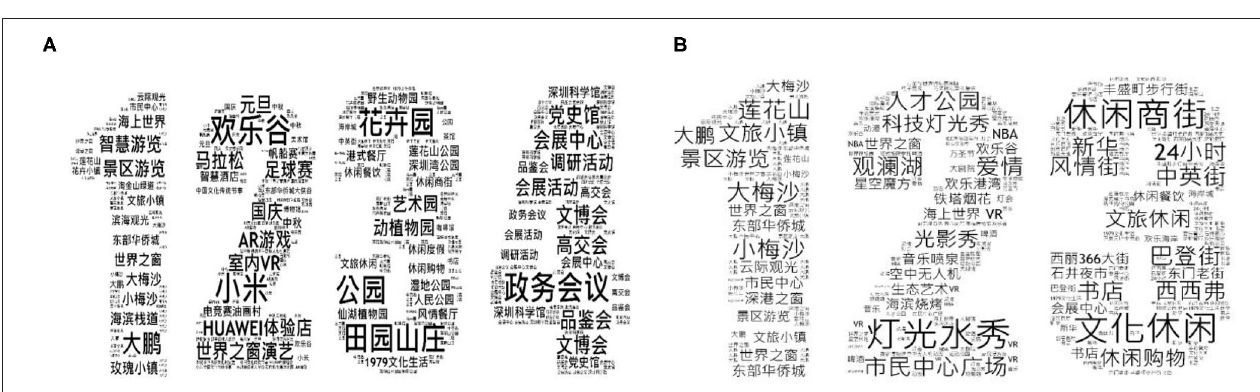
FIGURE 6 | Summary of word cloud diagram of daytime and night-time tourism economic patterns in Shenzhen. (A) Clustering of daytime tourism economic models in Shenzhen and (B) Shenzhen Night Tourism economic model clustering.